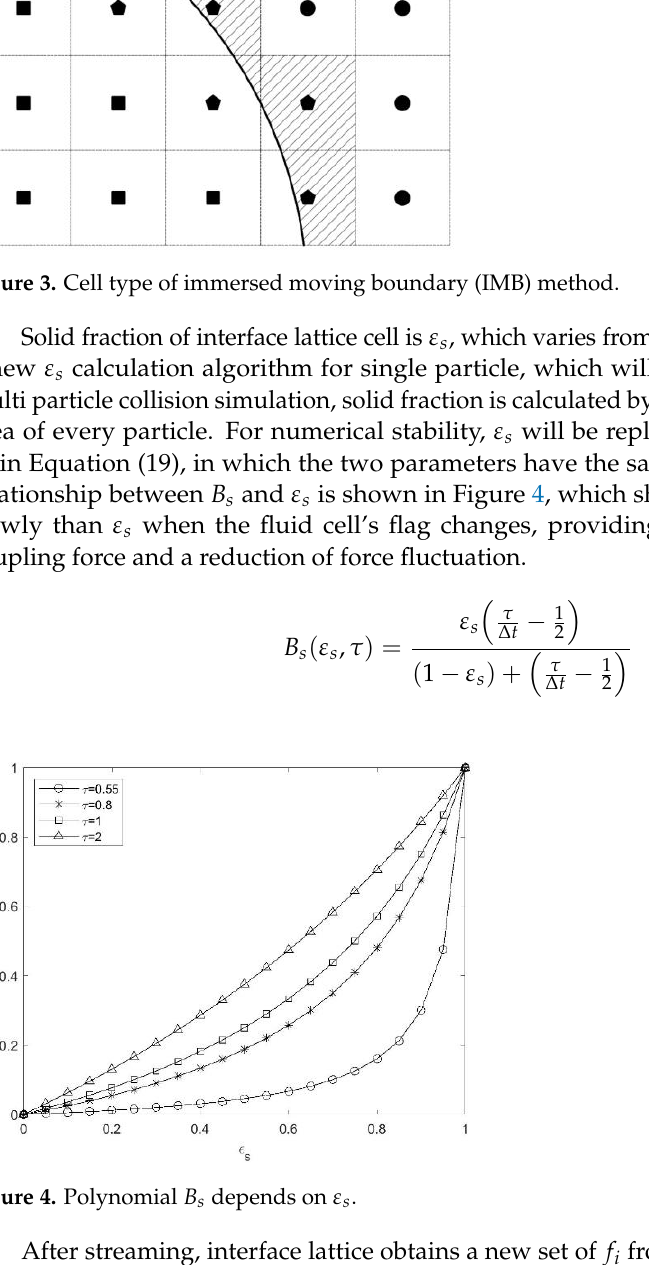
s depends on ε s